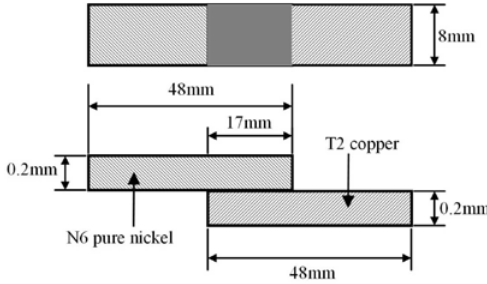
Figure 3. Geometry of the welded specimens.